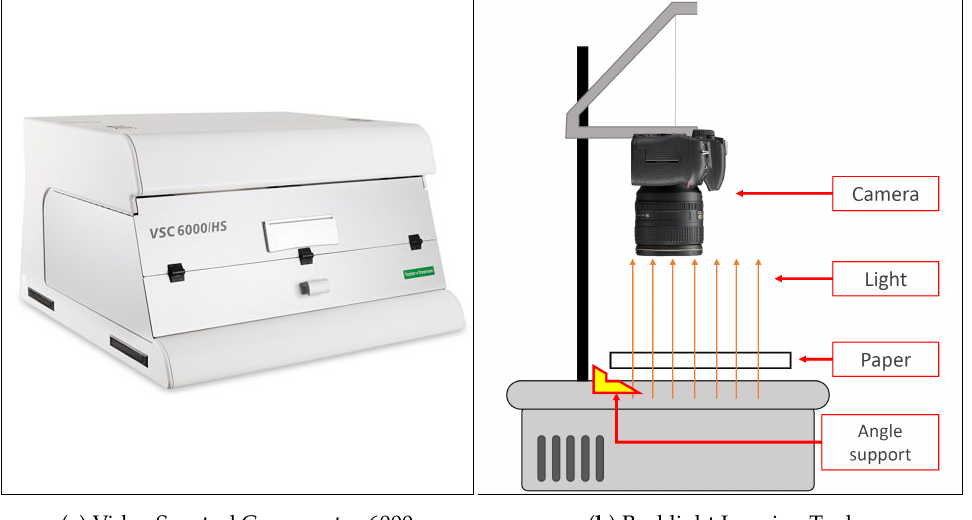
Figure 2. Devices employed for acquisitions.